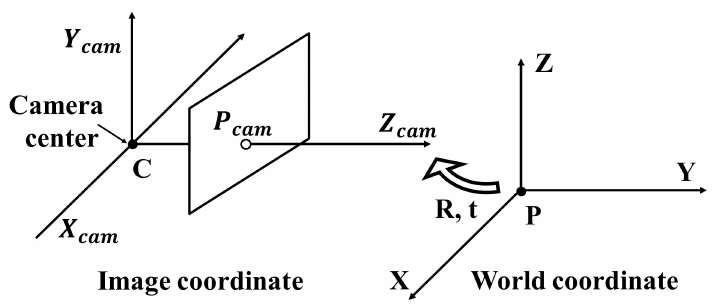
Figure 2. Calibration model of a camera in the dynamic workpiece modeling